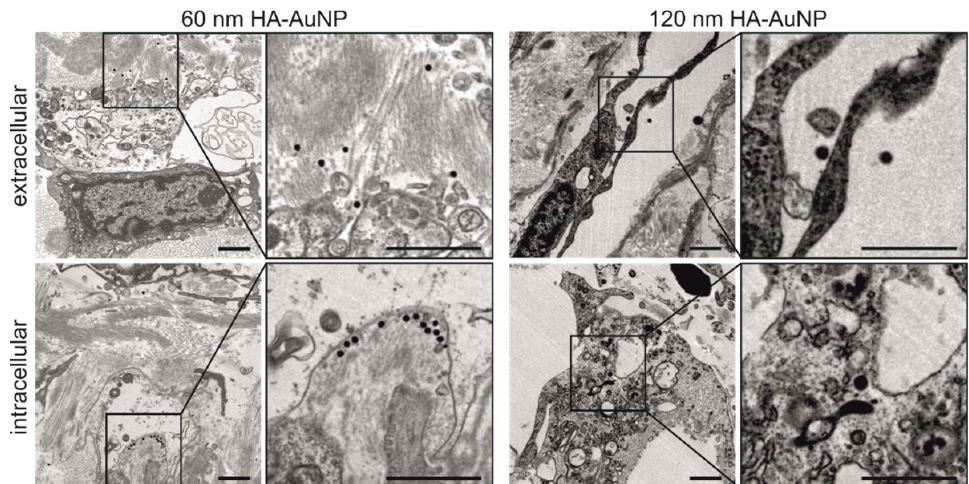
Figure 5. NP distribution within the trabecular meshwork after ex vivo perfusion with gold NPs. Both the 60 and 120 nm HA-AuNPs were located within the trabecular meshwork. Extracellular NPs were found in the extracellular matrix ( upper panel , overview image left ) and in the fluid egress pathway ( upper panel , magnification image right ). Intracellular NPs were detected in trabecular meshwork cells. Right-hand images are enlargements of the indicated areas of the left-hand images; scale bars represent 1 µm.